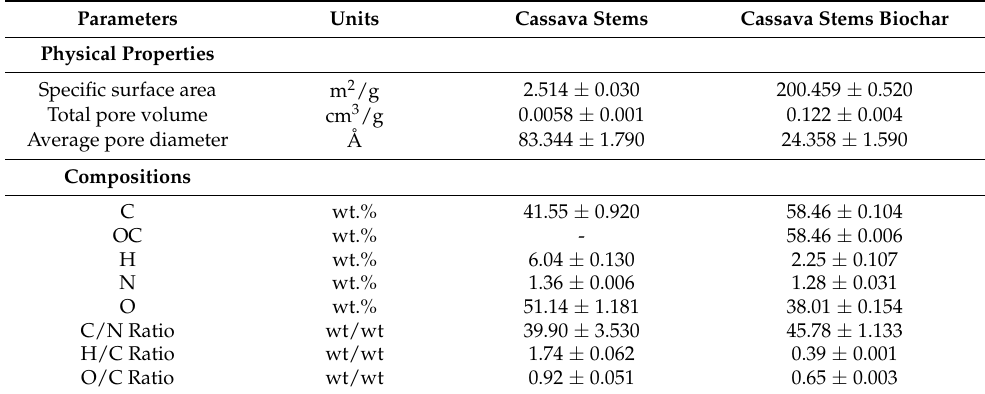
Table 1. Physical properties of cassava stems and cassava stem biochar.